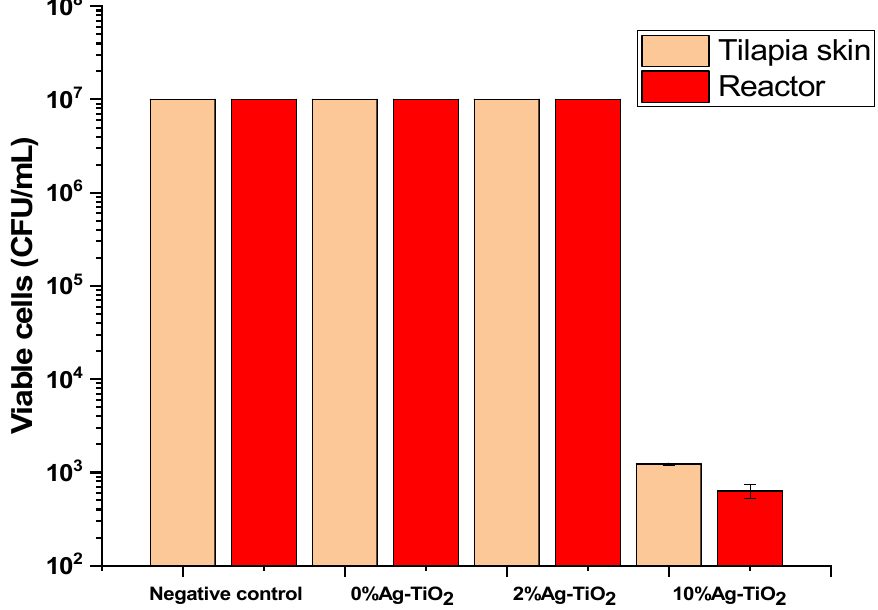
Figure 6. Biofilm inhibition evaluation for tilapia skin impregnated with mixed oxides: negative control, 10% Ag/TiO 2 , 2% Ag/TiO 2 , and 0% Ag/TiO 2 .